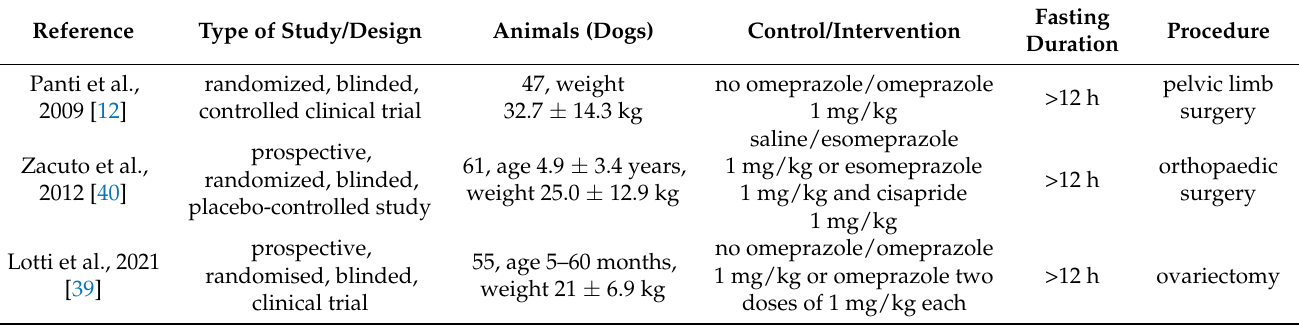
Table 5. Intervention: use of antacids. Characteristics of the studies in